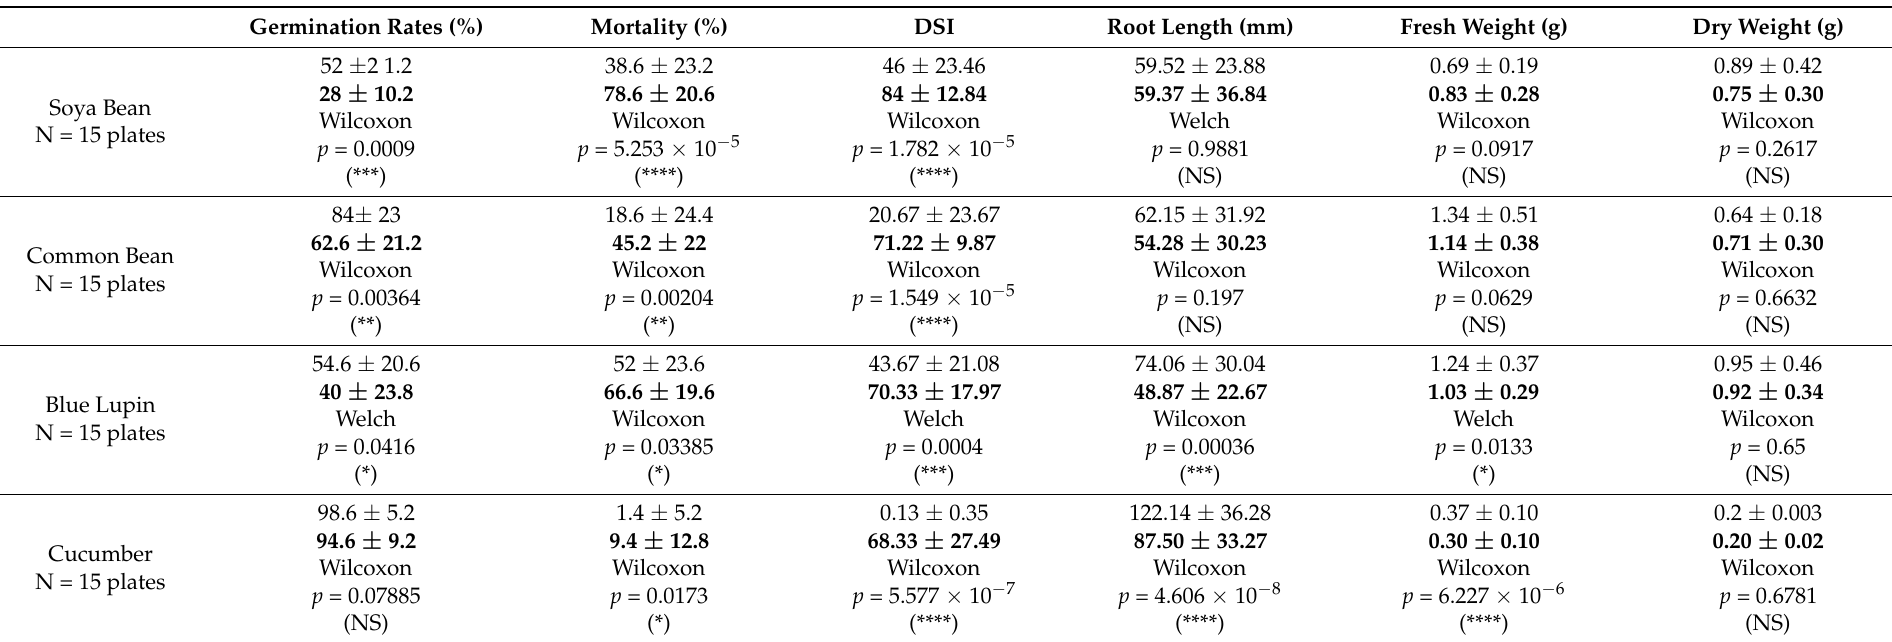
Table 1. In vitro assay data analysis: Germination rates, pathogenicity, disease severity index, root lengths and fresh and dry weights for control and inoculated pre-germinated seeds of plant species. Data are mean ± SD for each factor, with inoculated data in bold, the test used and the p -value. NS means p > 0.05, * means p ≤ 0.05, ** means p ≤ 0.01, *** means p ≤ 0.001, **** means p ≤